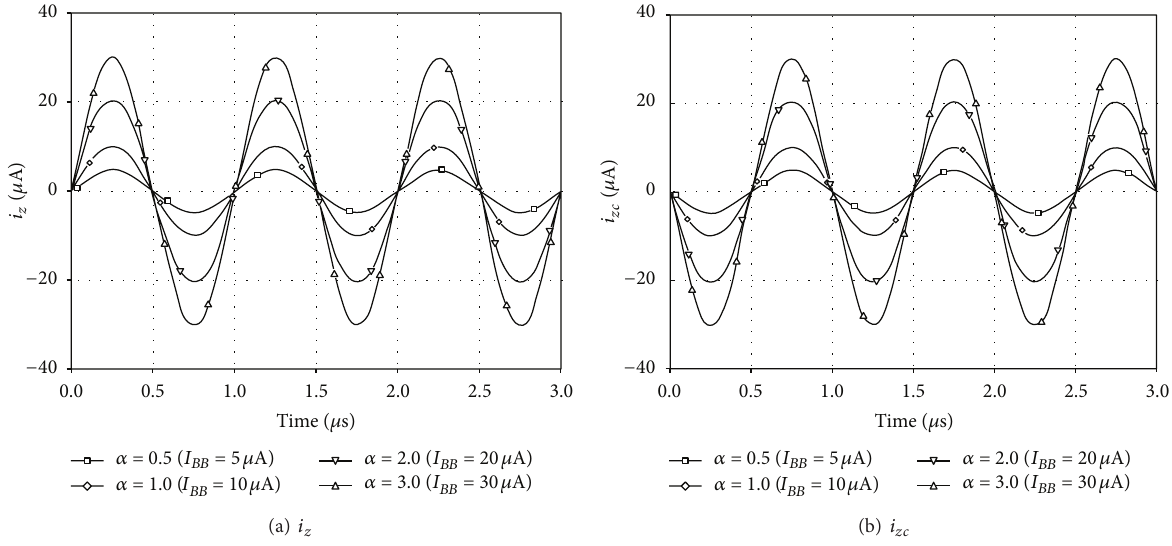
Figure 10: Time responses to a 10 𝜇 A sinusoidal signal at 1MHz for different values of 𝐼 𝐵𝐵 .